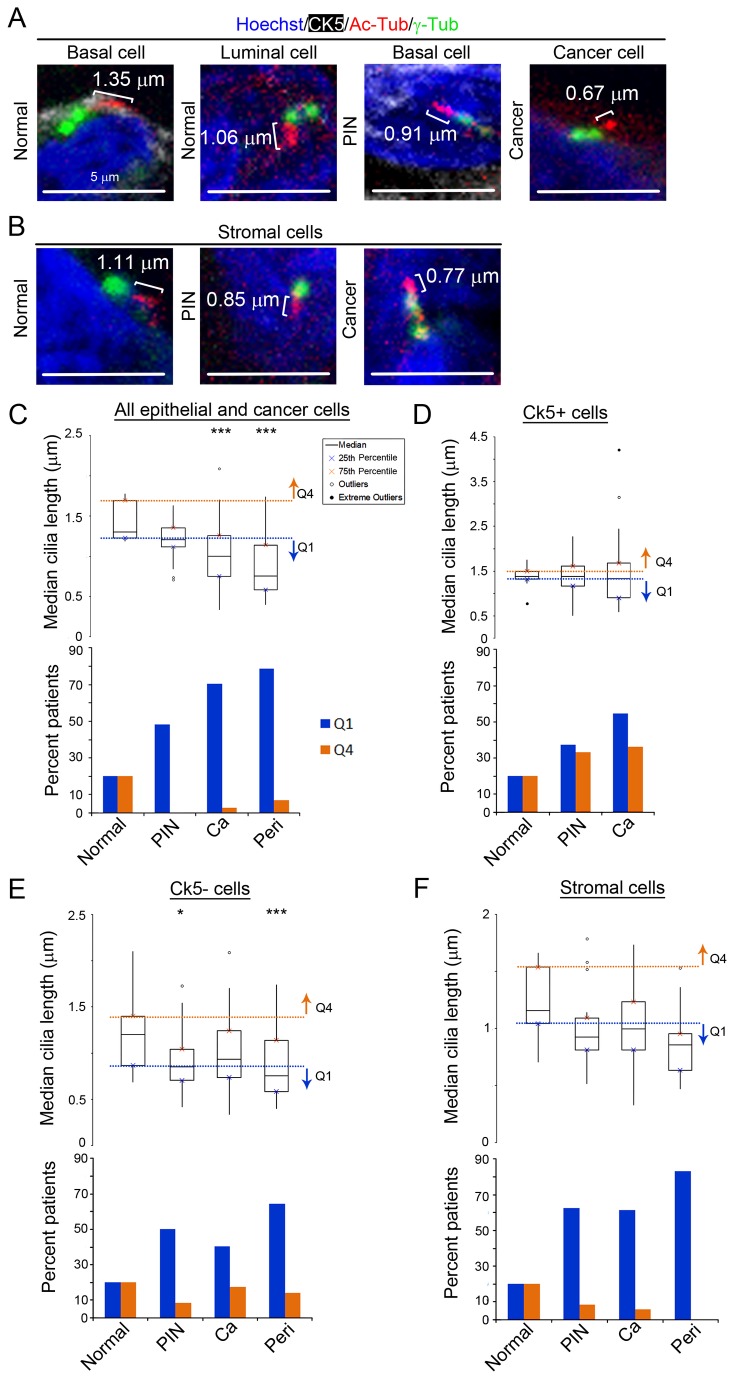
Ciliated prostate cancer and stromal cells have decreased axoneme lengths.(A and B) Primary cilia (Ac-Tub; red), centrosomes (γ-Tub; green), nuclei (Hoechst; blue), and cytokeratin 5 (CK5; white), are shown to illustrate representative ciliary lengths. Images were selected to represent the median length for normal and the 25th percentile for PIN and cancer cells (note that many PIN and cancer cells have cilia shorter than those shown). Cilia lengths are given. (A) Normal basal cell, normal luminal cell, CK5+ basal cell in PIN, CK5-cancer cell and (B) stromal cell in normal, PIN, and cancer tissue. Boxplots of cilia lengths for (C, top) all epithelial, (D, top) CK5+, (E, top) CK5-and (F, top) stromal cells per patient for normal, PIN, cancer (Ca), and perineural invasion (Peri). Q4, Q1 are as in Figure 1. Statistics were performed using linear regression (* = p<0.05, *** = p<0.001) (C, D, E, and F, bottom). The percent of patients with abnormally long cilia (Q4; orange) or abnormally short cilia (Q1; blue).